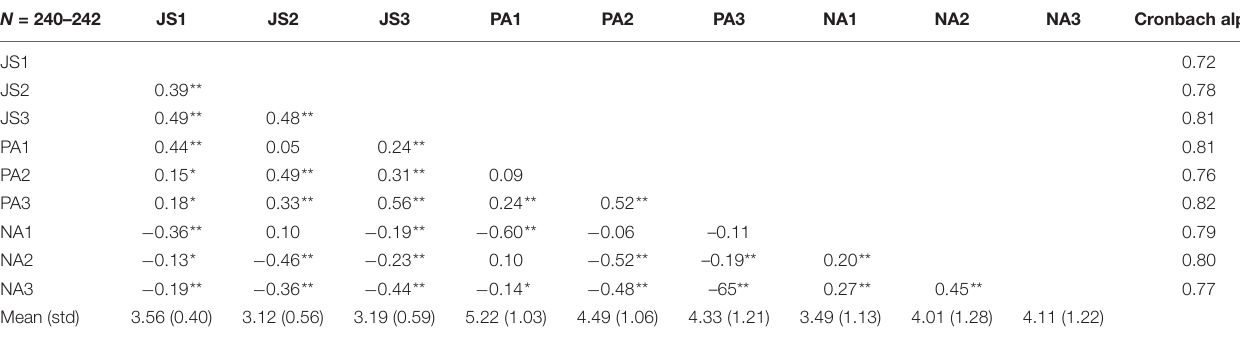
FIGURE 1 | Theoretical path model. TABLE 1 | Outcome scale correlations, reliabilities, means, and standard